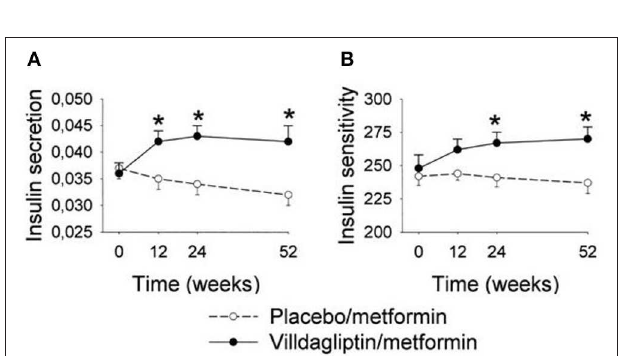
FIGURE 6 | Insulin secretion (pmol/l 30min)/(mmol/l) (A) and dynamic insulin sensitivity (oral glucose insulin sensitivity index, ml · min − 1 · m − 2 ) (B) at baseline (week 0) and after 12, 24, and 52 weeks of treatment with the DPP-4 inhibitor vildagliptin ( n = 31) or placebo ( n = 26) in metformin-treated subjects with type 2 diabetic. Means ± S.E.M. are shown. Data from Ahrén et al. (54) * P < 0.05 between the groups. Reprinted with permission from the American Diabetes